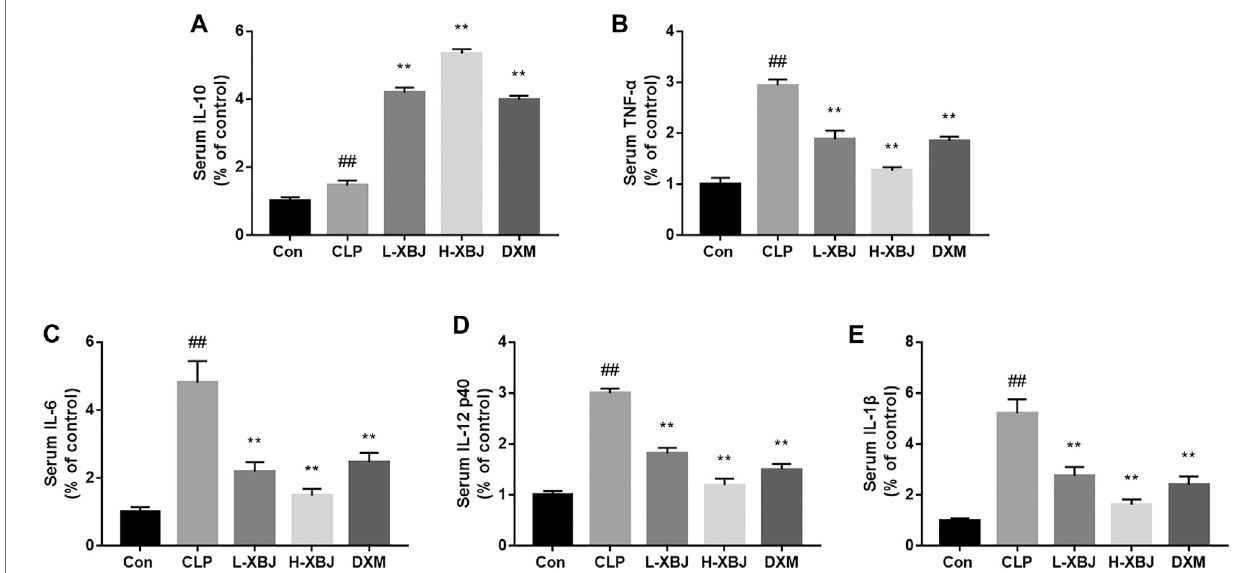
FIGURE3| XBJmodulatestheserumlevelsofin fl ammatoryfactorsinmicewithCLP-inducedALI (A) XBJincreasedIL-10inserumofmicewithCLP-inducedALI. (B) XBJ decreased TNF- α in serum of mice with CLP-induced ALI (C) XBJ decreased IL-6 in serum of mice with CLP-induced ALI. (D) XBJ decreased IL-12 in serum of mice with CLP-induced ALI (E) XBJ decreased IL-1 β in serum of mice with CLP-induced ALI. Con: control group that underwent sham surgery; CLP: model group with CLP surgery; L-XBJ: group with CLP surgery + XBJ low dose group (4 ml/kg/day); H-XBJ: group with CLP surgery + XBJ high dose group (8 ml/kg/day); DXM: group with CLP surgery + Dexamethasone (5 mg/kg/day). Compared with the control group, # p < 0.05, ## p < 0.01 were considered to be signi fi cant; Compared with the CLP group, * p < 0.05, ** p < 0.01 were considered to be signi fi cant. Data are expressed as mean ± SD.